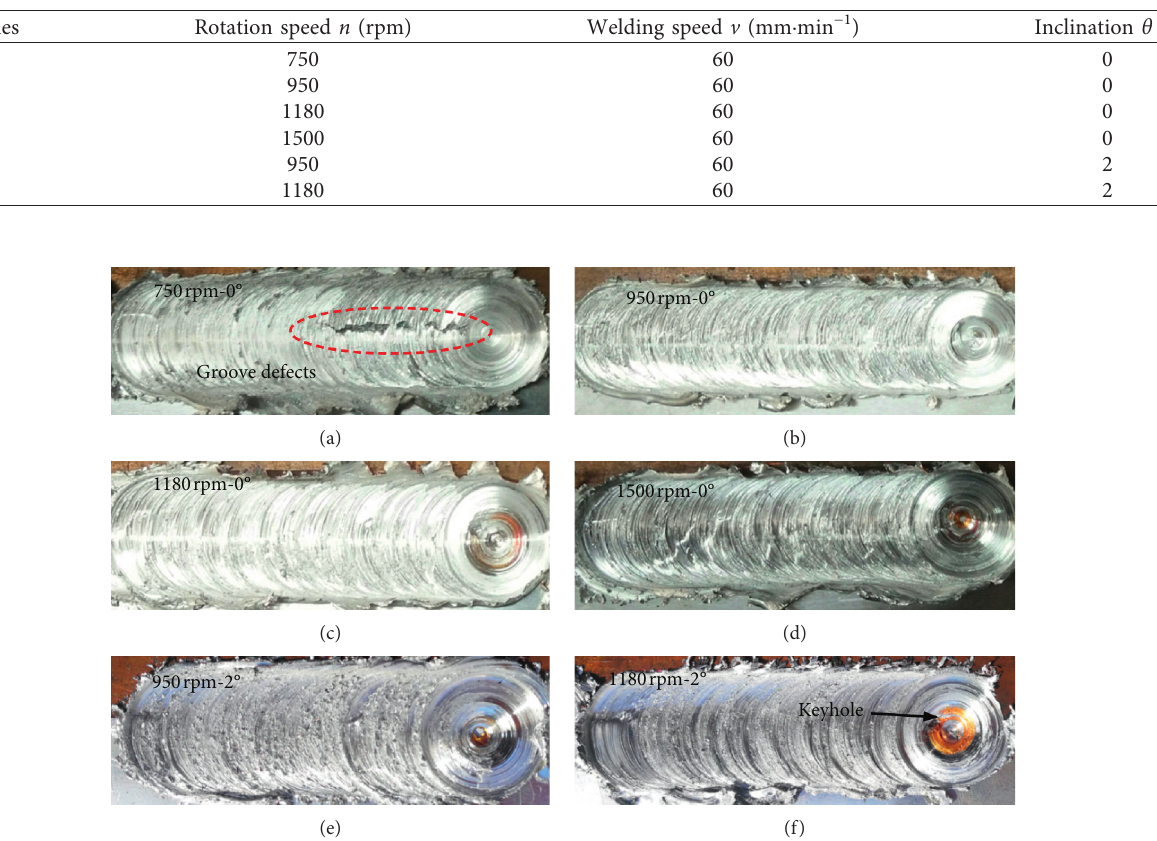
Figure 1: Experimental setup: (a) the schematic diagram of FSW process and (b) the stir tool. Table 1: The experimental parameters of the Al-Cu FSW process.